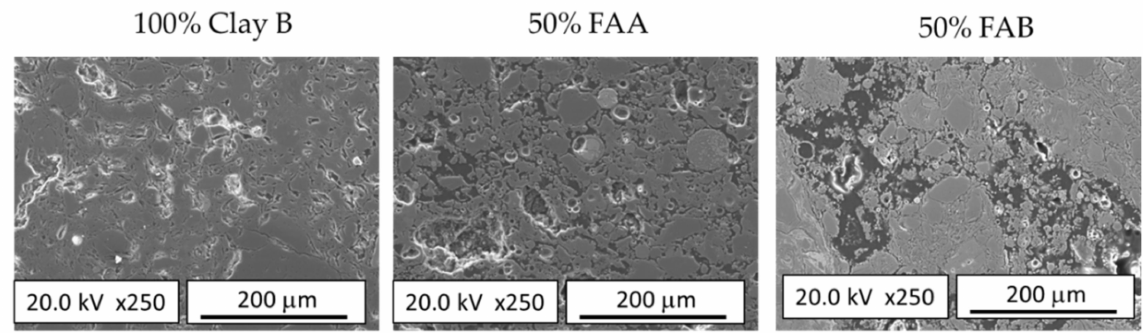
Figure 8. FESEM images of fired clay bricks: ( a ) FAA–Clay fired bricks; ( b ) FAB–Clay fired bricks.